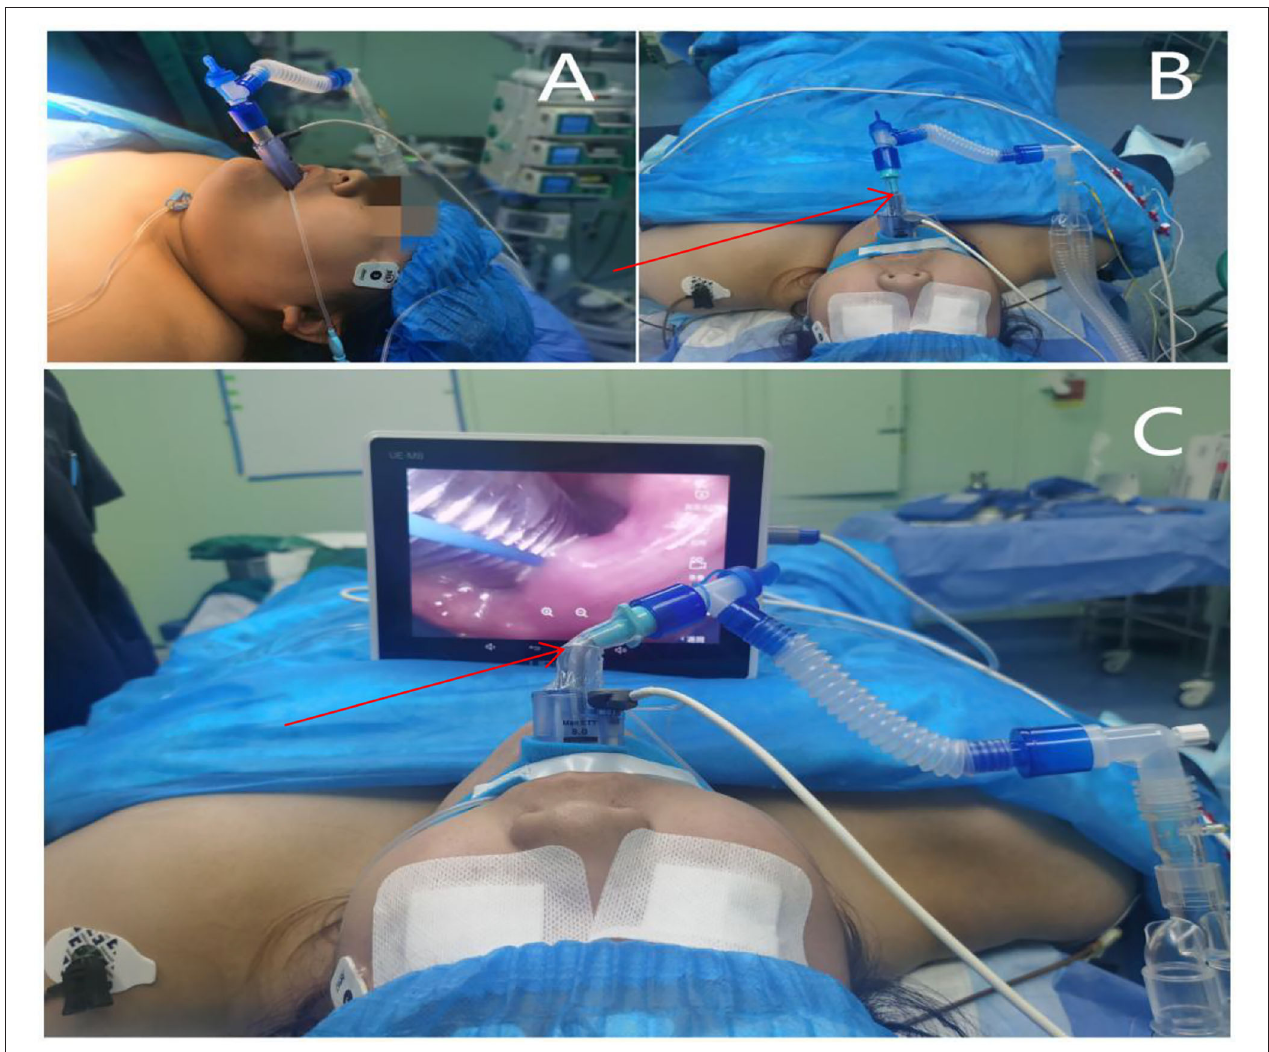
FIGURE 2 | Airway management, Fixed place of infusion paster (Ventilation lumen entrance and tracheal intubation).